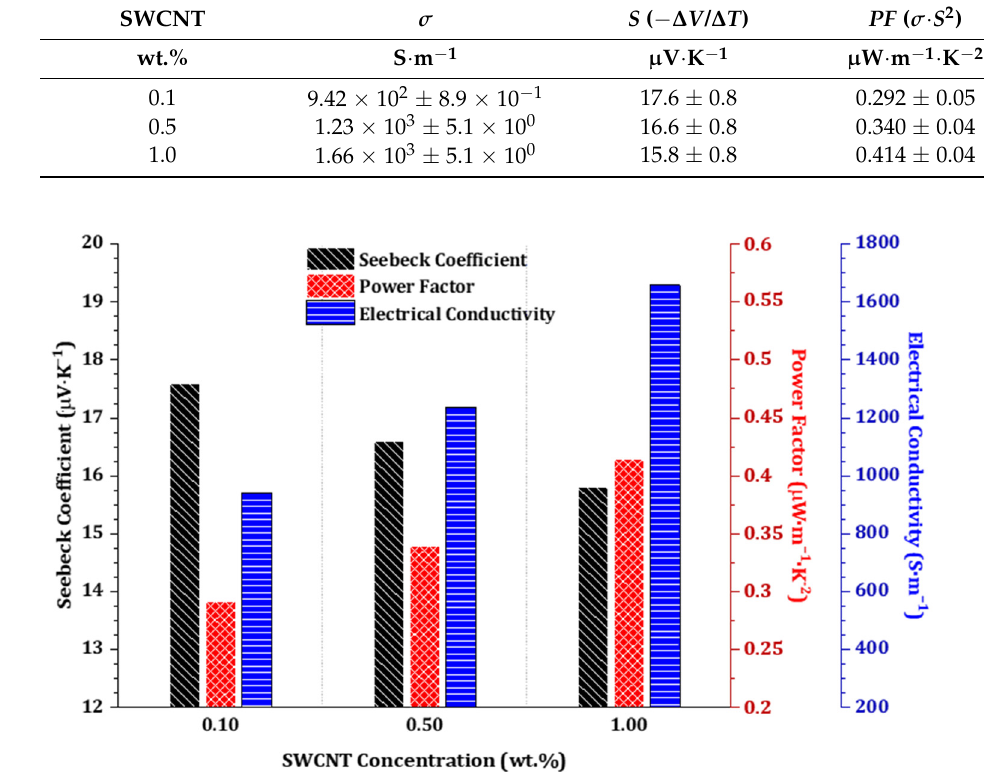
Figure 2. Thermoelectric properties of 28-day one-part SWCNT-alkali-activated nanocomposites.